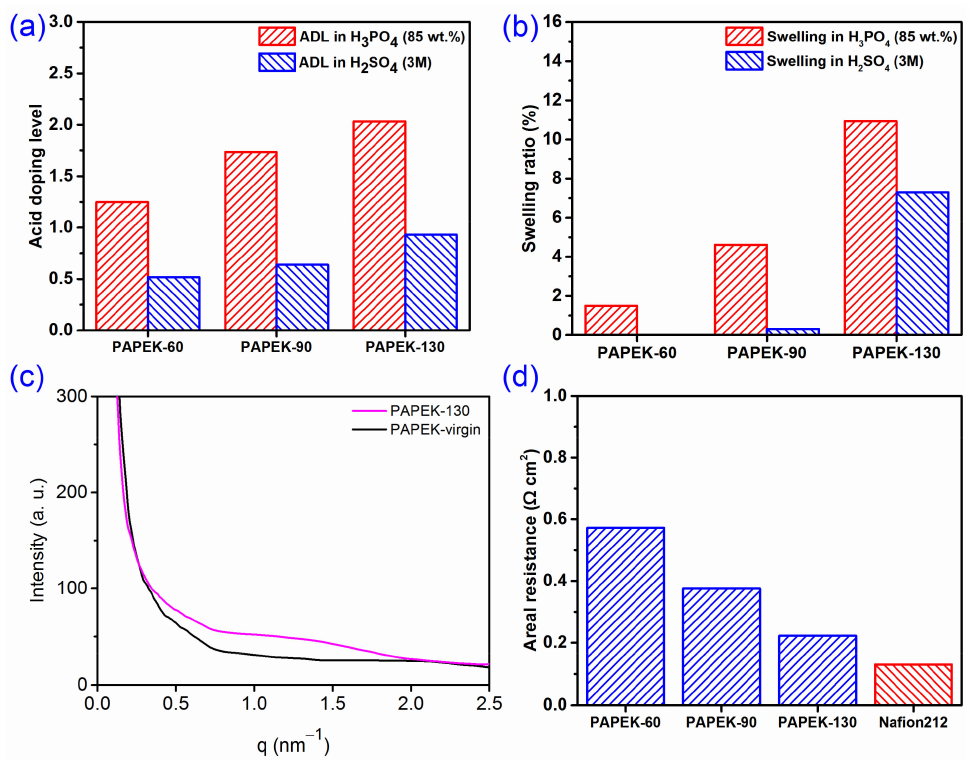
Figure 3. ADL ( a ), swelling ratio ( b ), SAXS ( c ), and areal resistance ( d ) of PAPEK